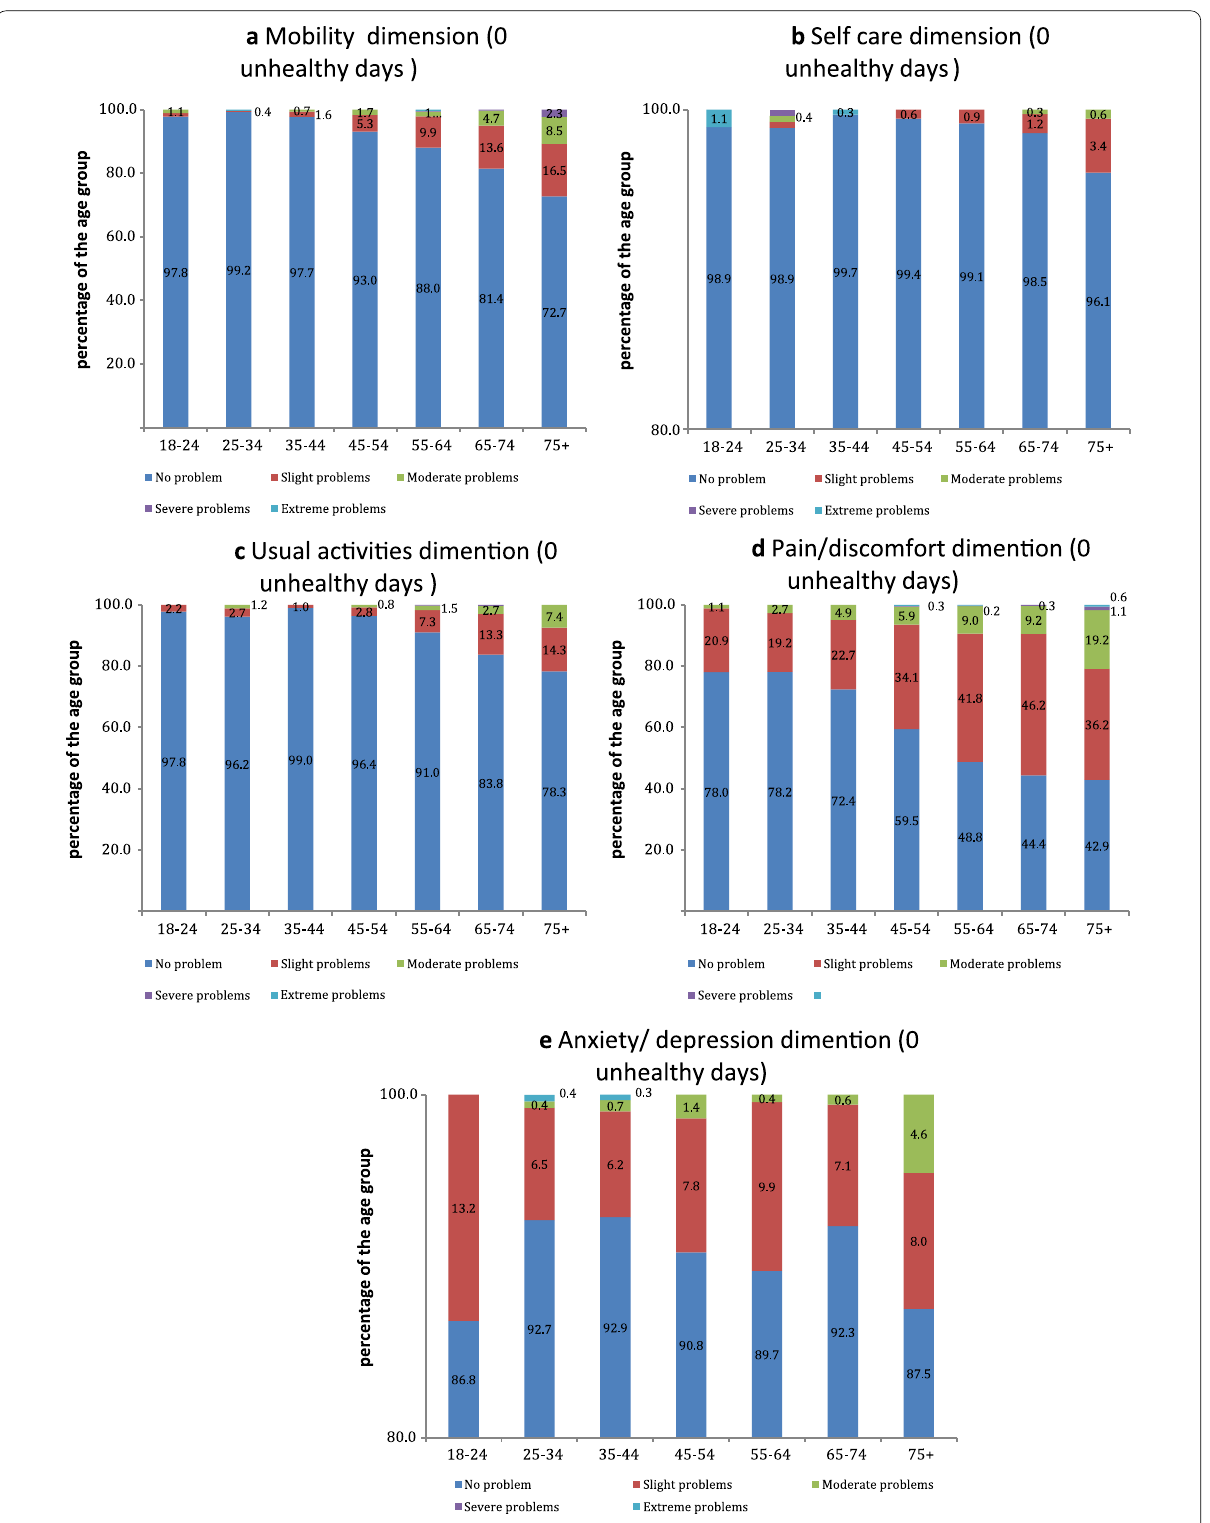
Fig. 3 EQ-5D-5L dimensions scores for the population subgroup of 0 unhealthy days by age